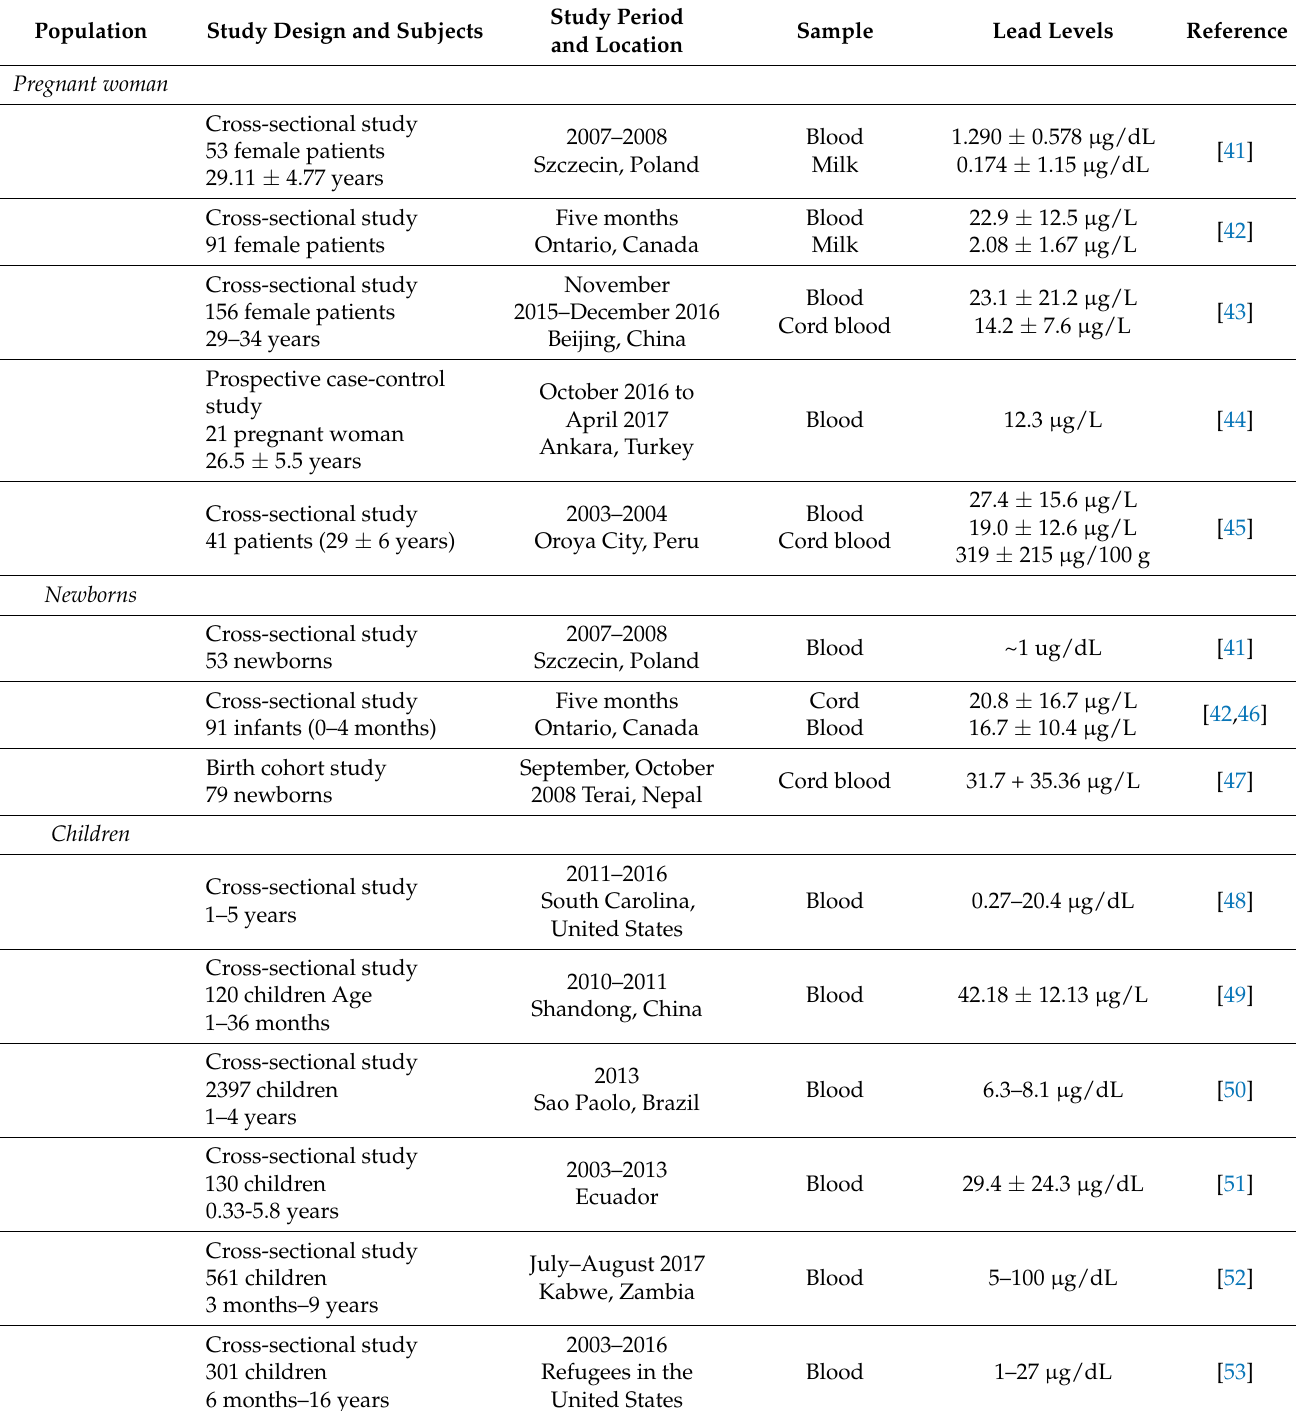
Table 2. Biomonitoring of human exposure to Pb in pregnant women and lifespan development. Study Period Sample Lead Levels Population Study Design and Subjects and Location